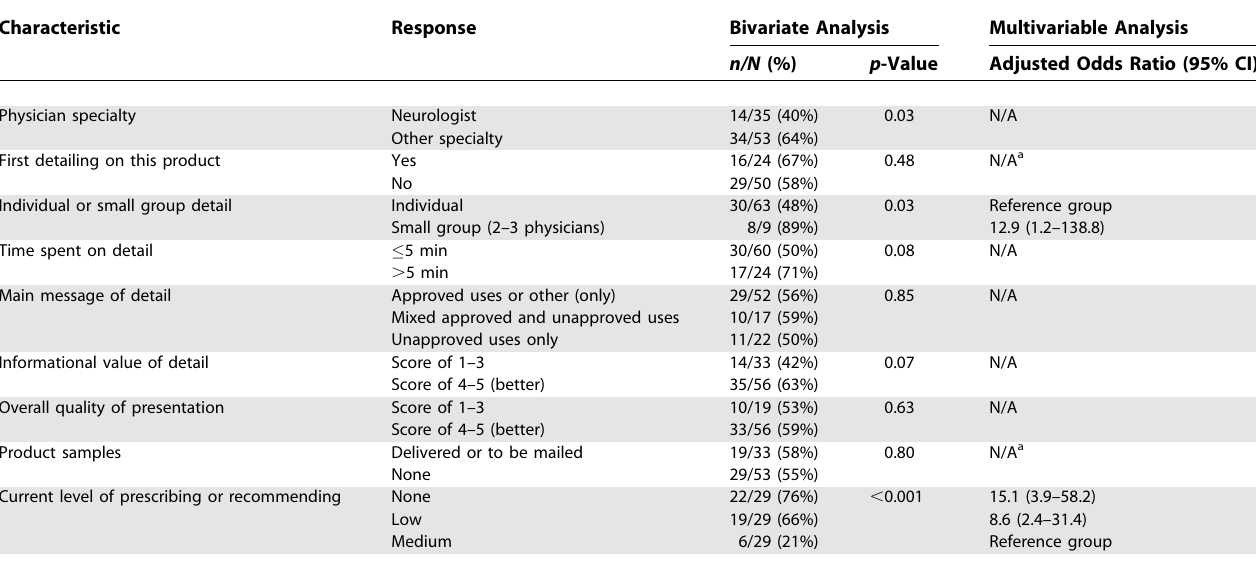
Table 2. Factors Associated with Intention to Increase Future Prescribing or Recommending of Gabapentin